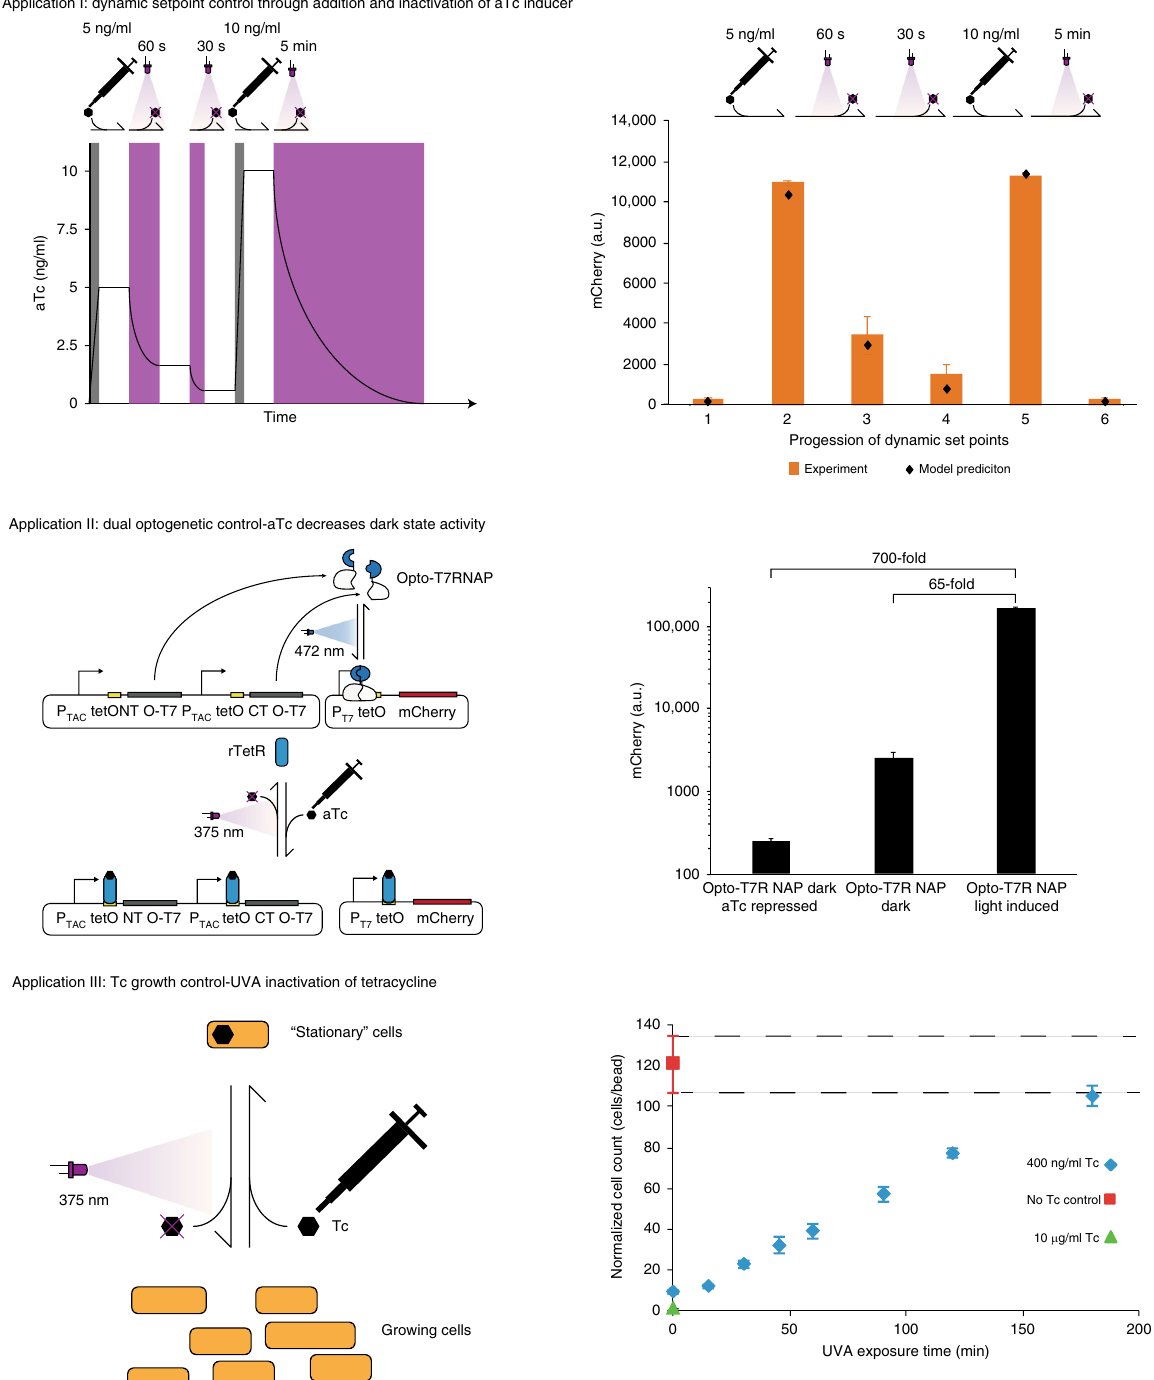
Fig. 3 Applications of aTc and Tc photodegradation. a Dynamic setpoint control through mCherry expression via addition of aTc and its removal through UVA. Schematic illustration ( a left) of aTc concentration change in the dynamic experiment ( a right) through the aTc addition and UVA degradation inputs. Cells expressing TetR which again controls expression of mCherry without aTc (condition 1), after addition of aTc to 5ng/ml (condition 2), partial aTc removal through 60s UVA illumination (condition3),furtherremovalthroughasecondUVApulseof30s(condition4),thenadditionofaTcto10ng/ml(condition5),and fi nallycompleteaTcremovalwithaUVA pulse of 5min (condition 6). Diagrams show mean mCherry expression values and standard deviation of three biological replicates in orange bars and black diamonds for mathematical predictions, using our parameterized model. b Dual optogenetic control of mCherry expression. rTetR is used to reduce dark state expression of Opto-T7RNAP* (563) in the presence of aTc ( b left), effectively increasing the dark to light fold change of the optogenetic system from ~65- to ~700-fold ( b right). c Light-inducible control of growth rate with Tc. Tc can be added directly and inactivated with UVA to shift cells between “ stationary ” and growing cells ( c left). The antibiotic is inactivated through UVA illumination (4.1mW/cm 2 ) over time, which leads to intermediate growth rates ( c right) or complete removal of the antibiotic with growth rates comparable to the control without Tc. Diagrams show mean values and standard deviation of three biological replicates ( n = 3) of mCherry values for gene expression experiments, and cell counts normalized to counting beads for growth experiments measured after 5h incubation time in all cases. Source data are provided as a Source data fi